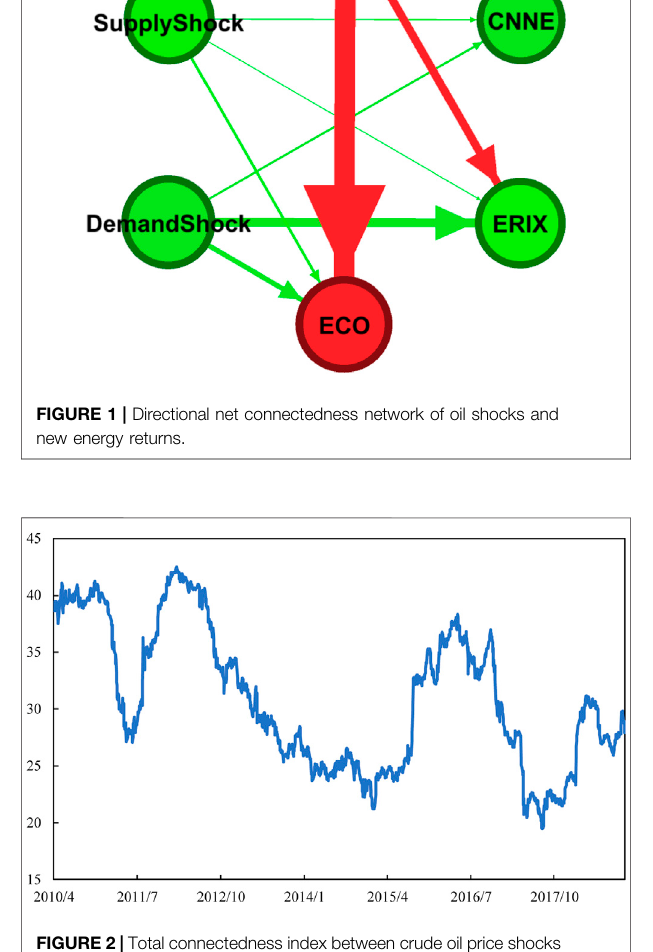
FIGURE 2 | Total connectedness index between crude oil price shocks and new energy returns over time (The rolling window is set to 200 days 1 ).